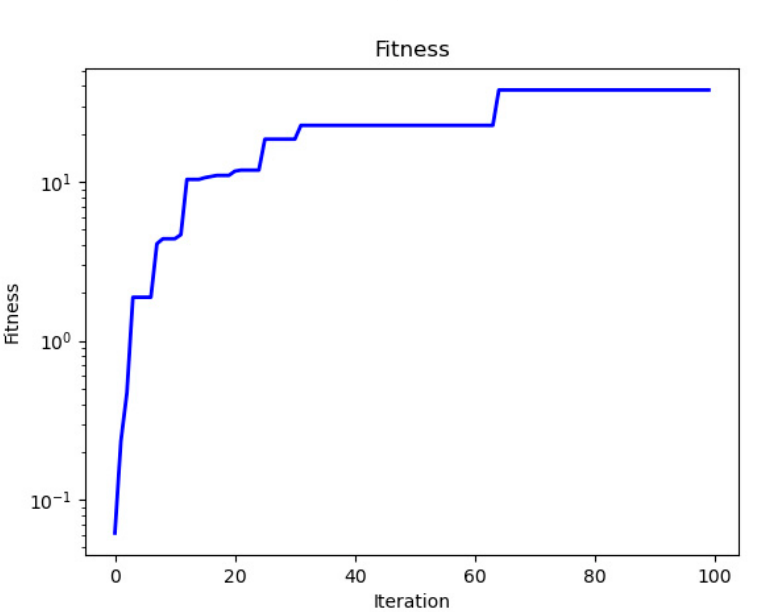
The iteration and corresponding fitness of dataset three are shown in Figure 7.